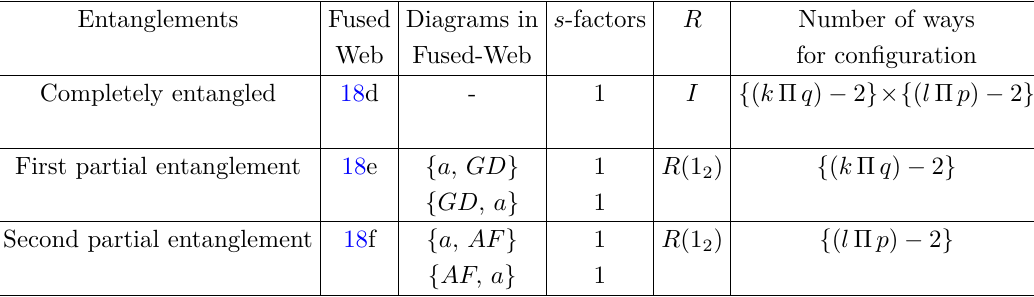
Table 7. Fused-Webs and their mixing matrices for Cweb W (1 , 1 , 1)